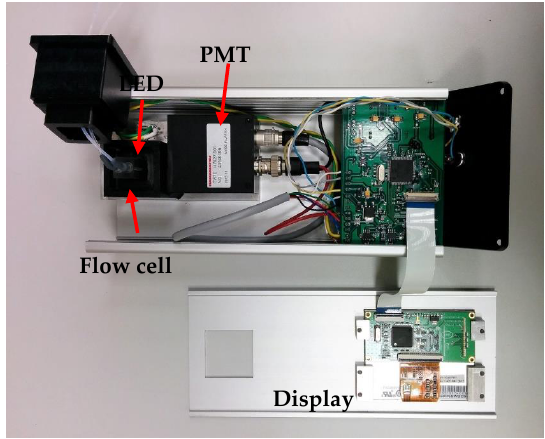
Figure 6. Image of the portable prototype of the instrument designed for photoluminescence measurements.